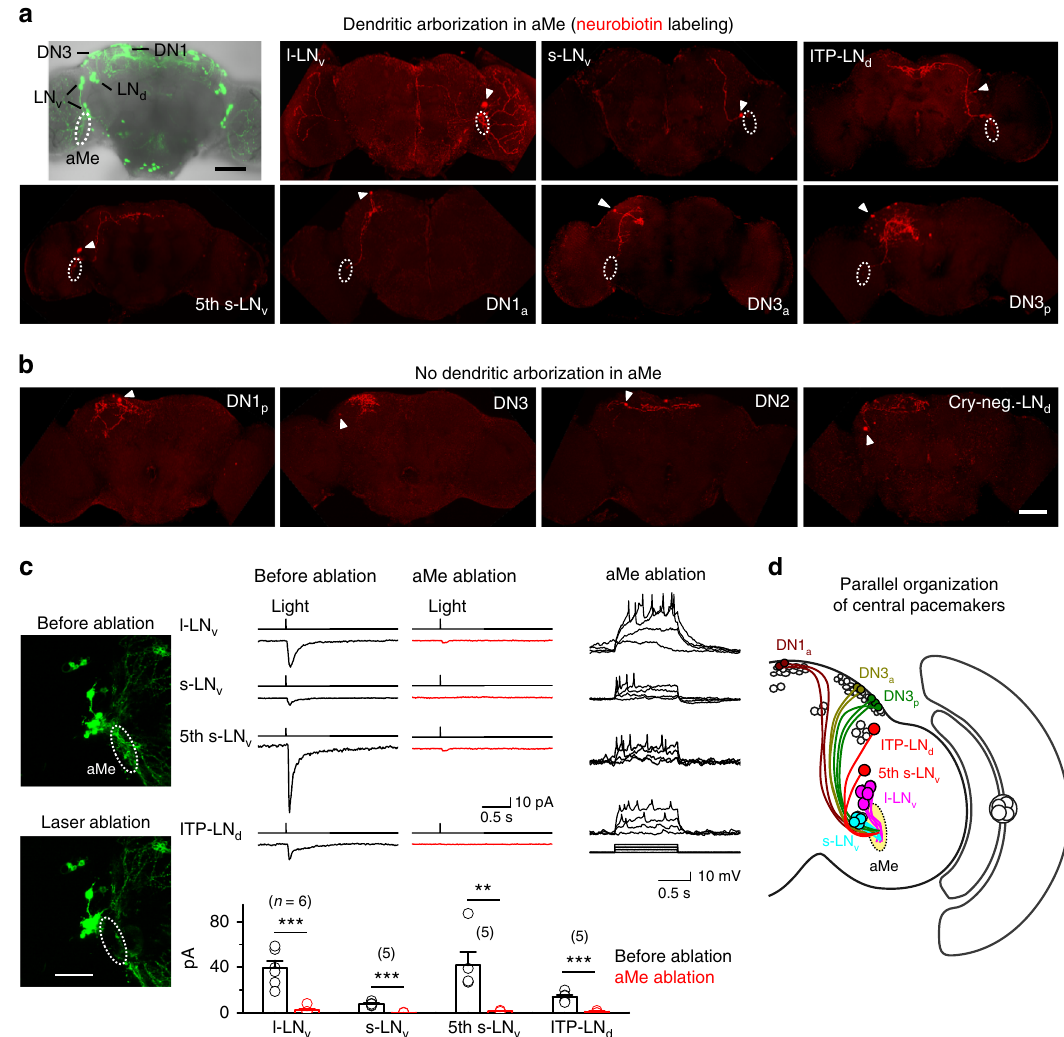
Fig. 4 aMe channels visual inputs to central pacemaker neurons. a aMe arborization revealed by single-cell neurobiotin labeling. Overlay of DIC and GFP images shows the aMe and pacemaker neurons (top, left panel). The other panels show neurobiotin immunostaining of individual pacemaker neurons, with cell bodies marked by arrowheads. Dashed circles indicate the aMe. Scale bar, 50 μ m. b Light-insensitive pacemaker neurons (DN1p, DN2, DN3, and Cry- negative LNd cells) do not send any processes to the aMe. Cell bodies are indicated by arrowheads. Scale bar: 50 μ m. c aMe is required for light responses of pacemaker neurons. Left: laser ablation of the aMe, with images before (top) and after (bottom) ablation. Dashed lines indicate the aMe. Laser: 800nm, 50 mW. Scale bar, 50 μ m. Middle, light responses of the same l-LNv, s-LNv, fi fth s-LNv, and ITP-LNd cells before and after the aMe ablation (top) and the average results (bottom). Right, pacemaker neurons are able to be electrically excited in fl ies with the aMe ablated. Current steps: 2 pA. All of the eight repeated experiments show similar results. n = 6, 5, 5, and 5 for l-LNv, s-LNv, fi fth s-LNv, and ITP-LNd, respectively; error bars represent SEM; ** P < 0.01; *** P < 0.001. d Schematic illustration of independent visual inputs to the pacemaker